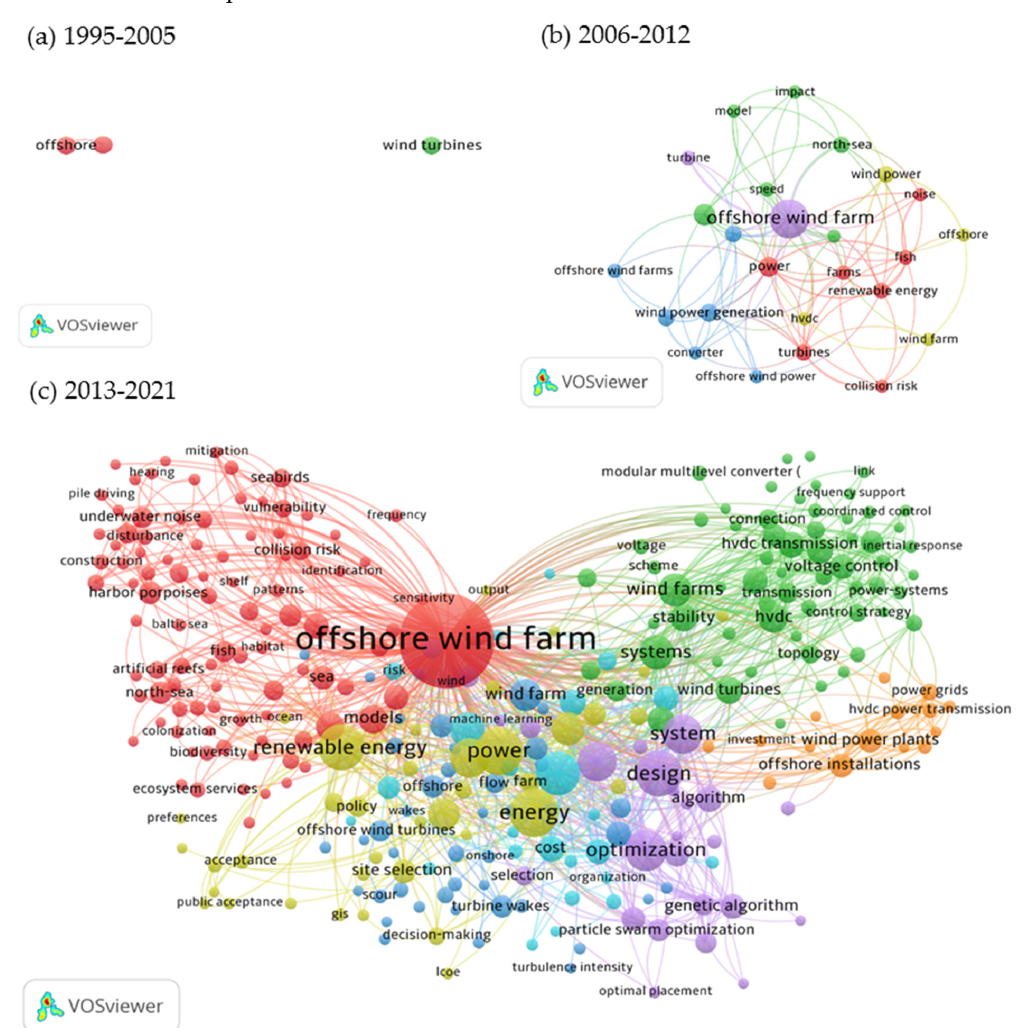
Figure 4. The international cooperation networks for offshore wind farm research: ( a ) first stage, ( b ) second stage, and ( c ) third stage.